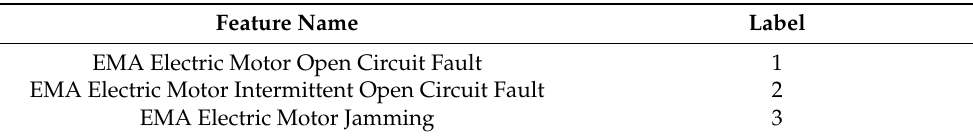
Table 3. Data Obtained from EBS